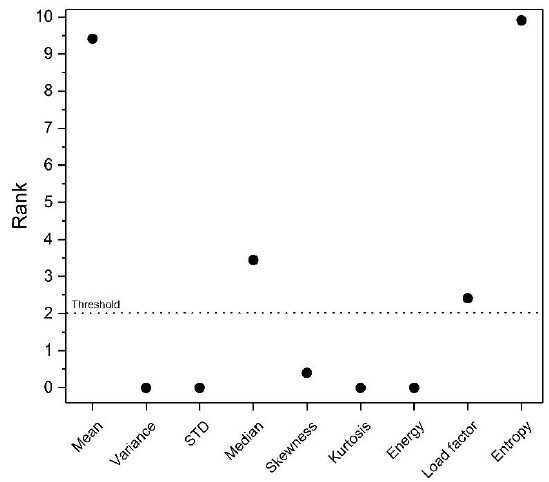
Figure 4. Ranking of the selected classification features.